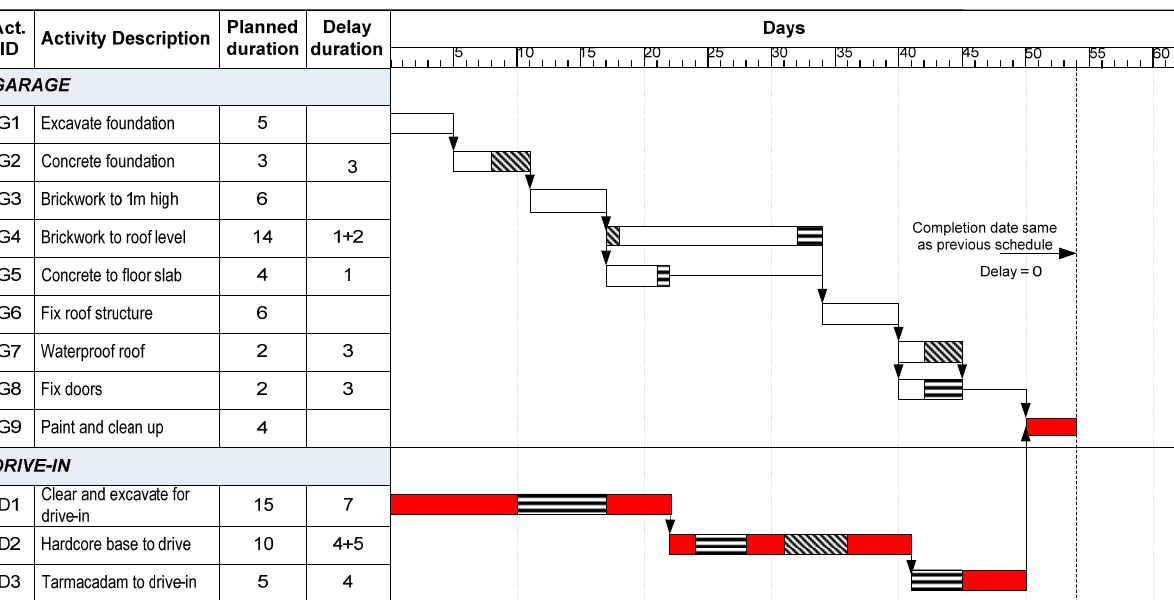
Figure 13. Impact of ninth and tenth delays.